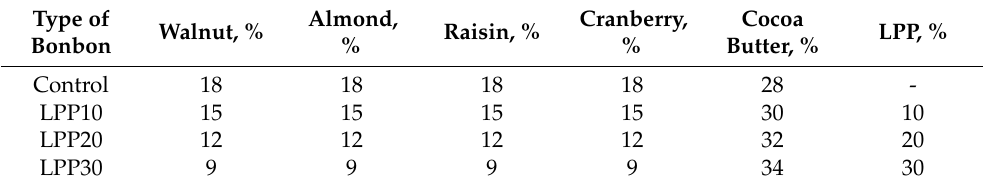
Table 1. Bonbon formulations: LPP—lyophilized peach powder. Type